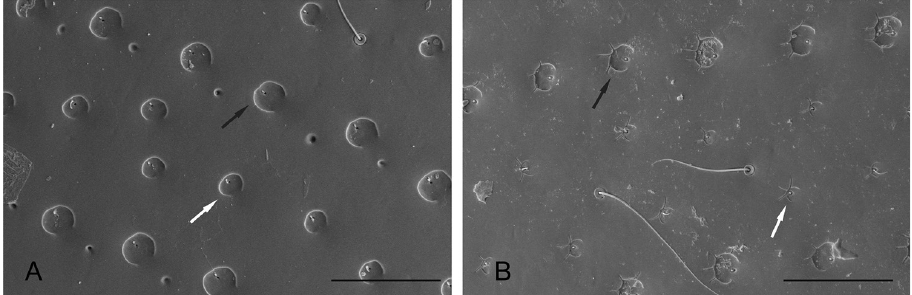
Figure 6. SEM of elytral punctures: A Q. clusia B Q. reticulatus . Scale bar: 50 µm. Black arrows point to serial punctures. White arrows point to interstrial